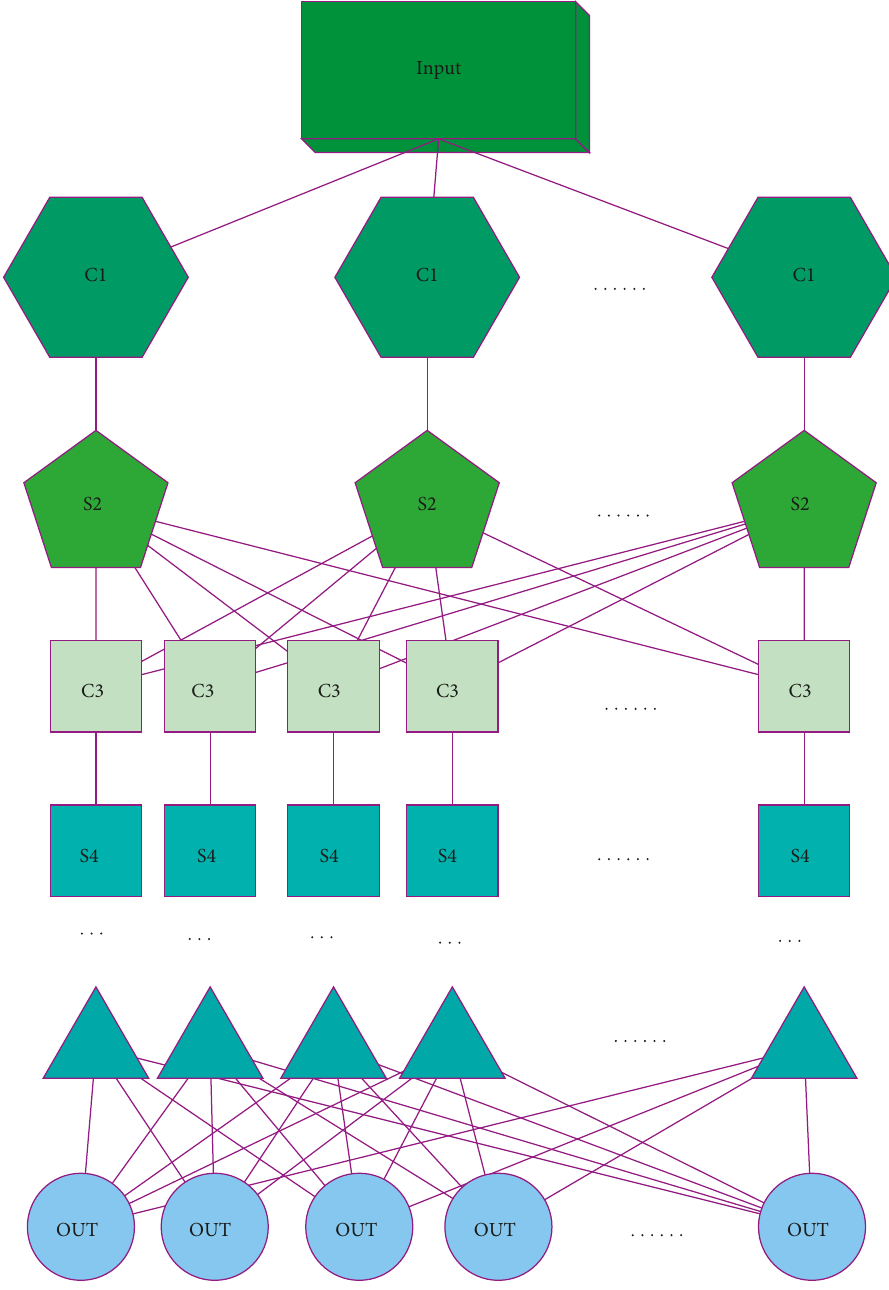
Figure 7: Deep convolutional neural network